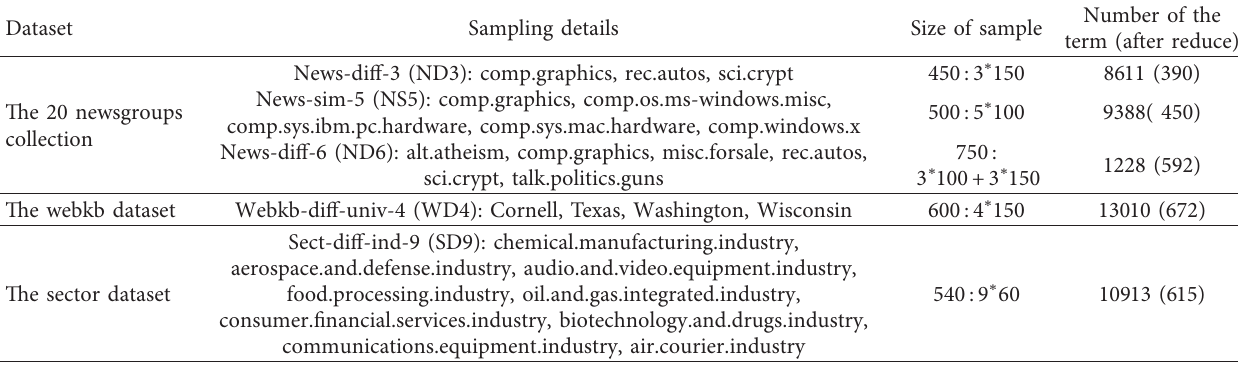
Table 1: Details of dataset for evaluation.